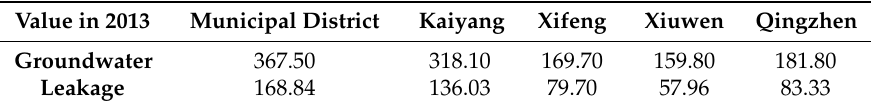
Table 7. Groundwater and simulated values of leakage in each district of Guiyang. Unit: million m 3